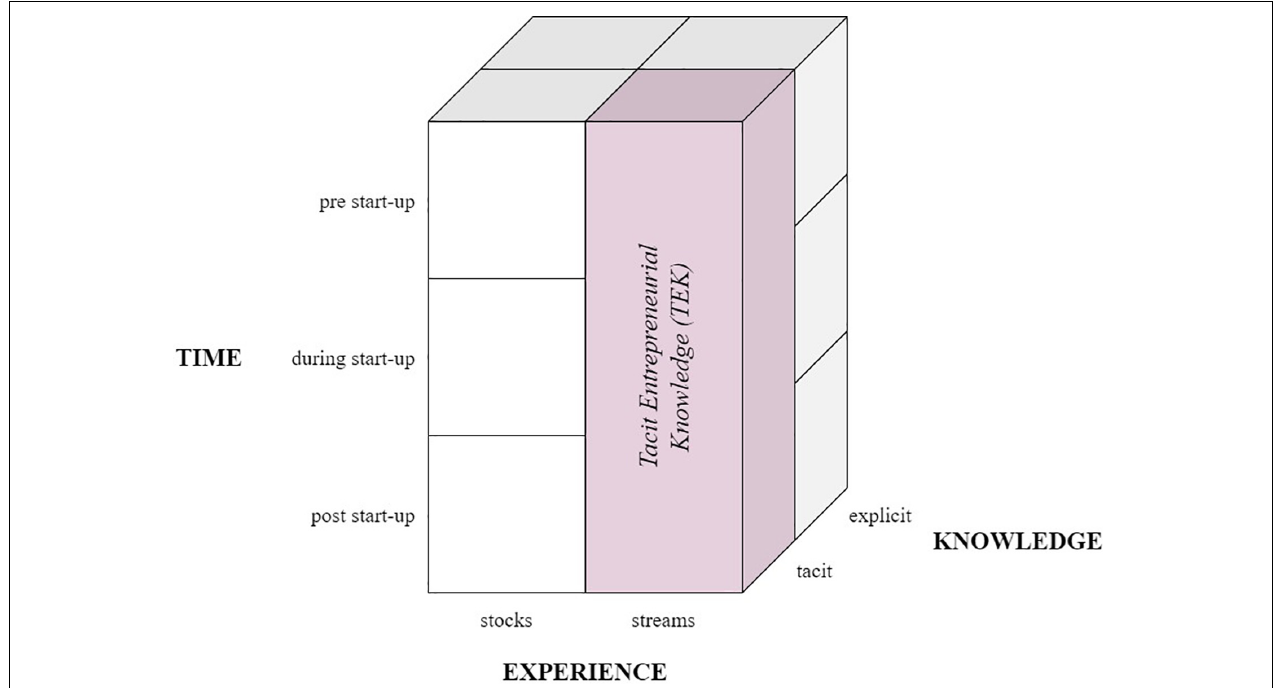
FIGURE 1 | Three-dimensional framework of Tacit Entrepreneurial Knowledge’s (TEK) basic characteristics.